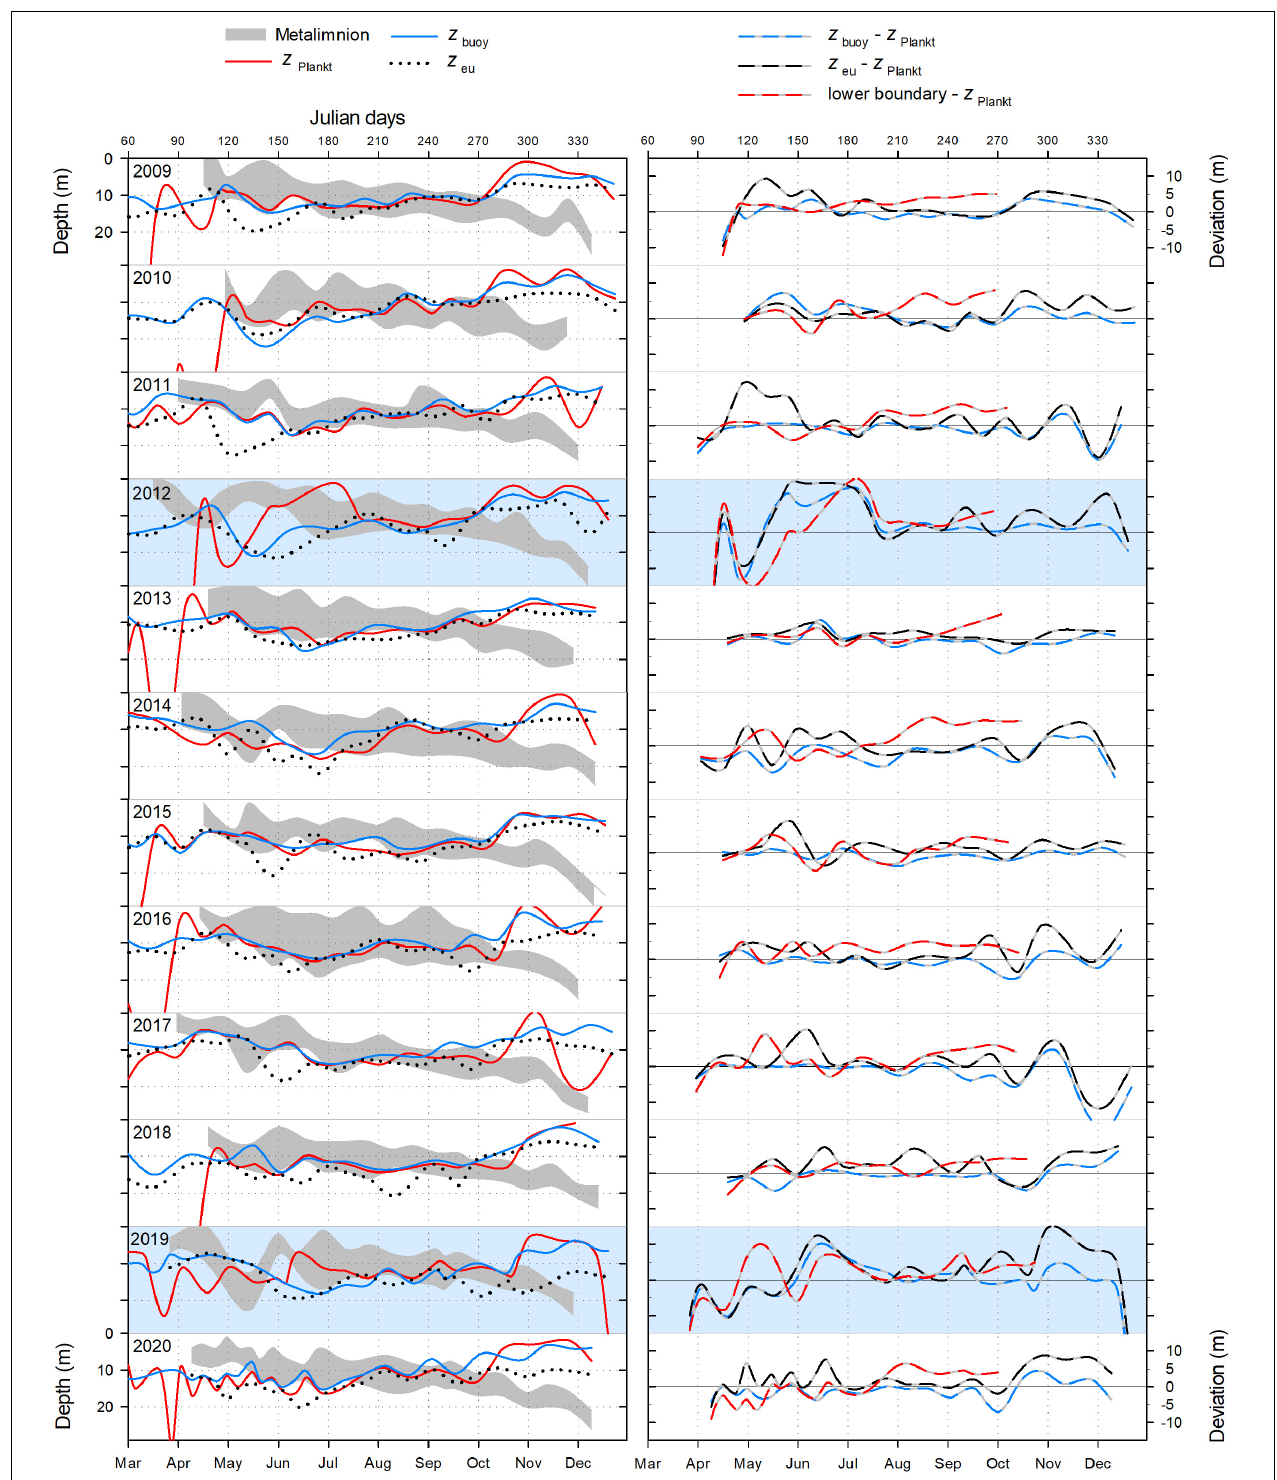
FIGURE 7 | Left panels: Metalimnion expansion, the depth of P. rubescens chlorophyll a concentration maximum ( z Plankt ), the thickness of the euphotic zone ( z eu ), and the neutral buoyancy depth ( z buoy ) in Lake Zurich from 2009 to 2020. Right panels: Congruence between z Plankt and z buoy , the lower boundary of the metalimnion, and z eu . Lines are based on subtraction of the depth of interest minus z Plankt . Positive deviations (m) indicate that the P. rubescens maximum was found less deep than the parameter of comparison, and vice versa for negative deviations (m). Note the striking incongruence between parameters during spring 2012 and 2019 (years are indicated by a blue